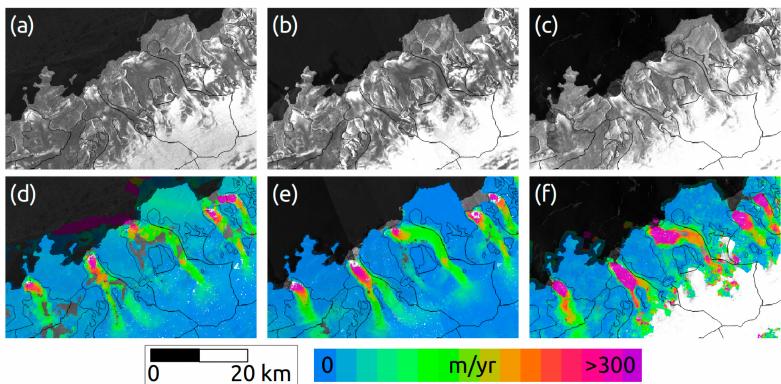
Figure 13. JERS-1 SAR 1998 backscattering intensity image and velocity map ( a , d ) ALOS-1 PALSAR-1 2009/2010 backscattering intensity image and velocity map ( b , e ) and Sentinel-1 2016 backscattering intensity image and velocity map ( c , f ) over marine-terminating glaciers along the Barents Sea coast of Novaya Zemlya.